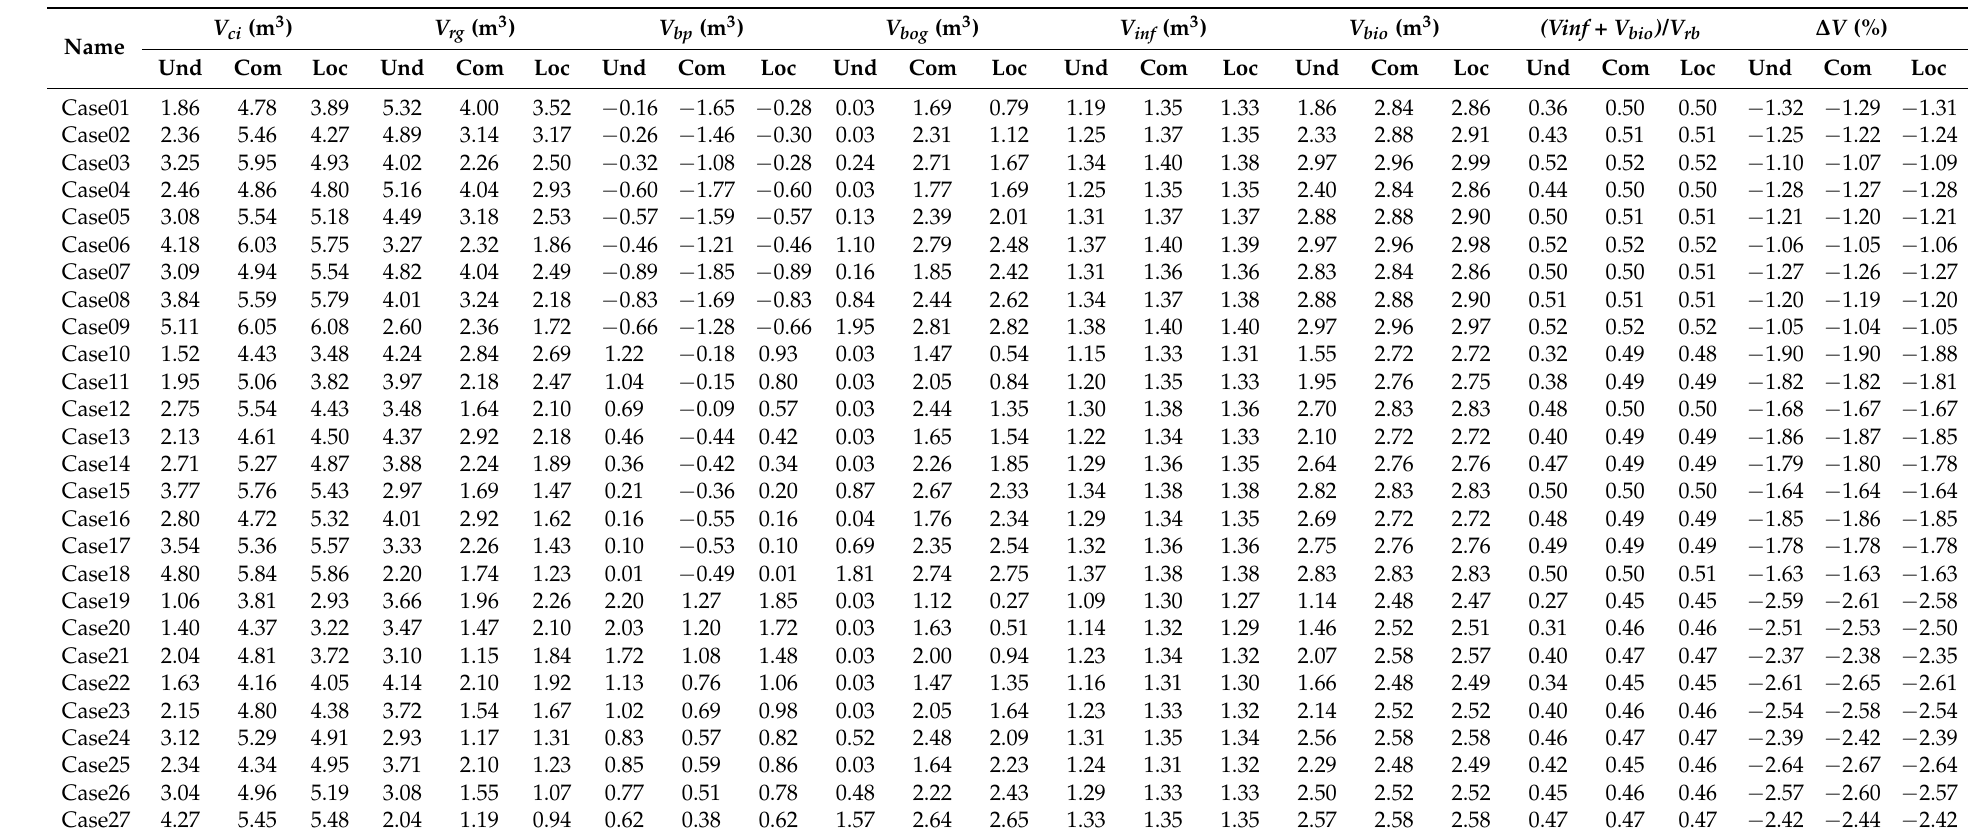
Table 4. Simulation results of road-bioretention cases with three types of curb